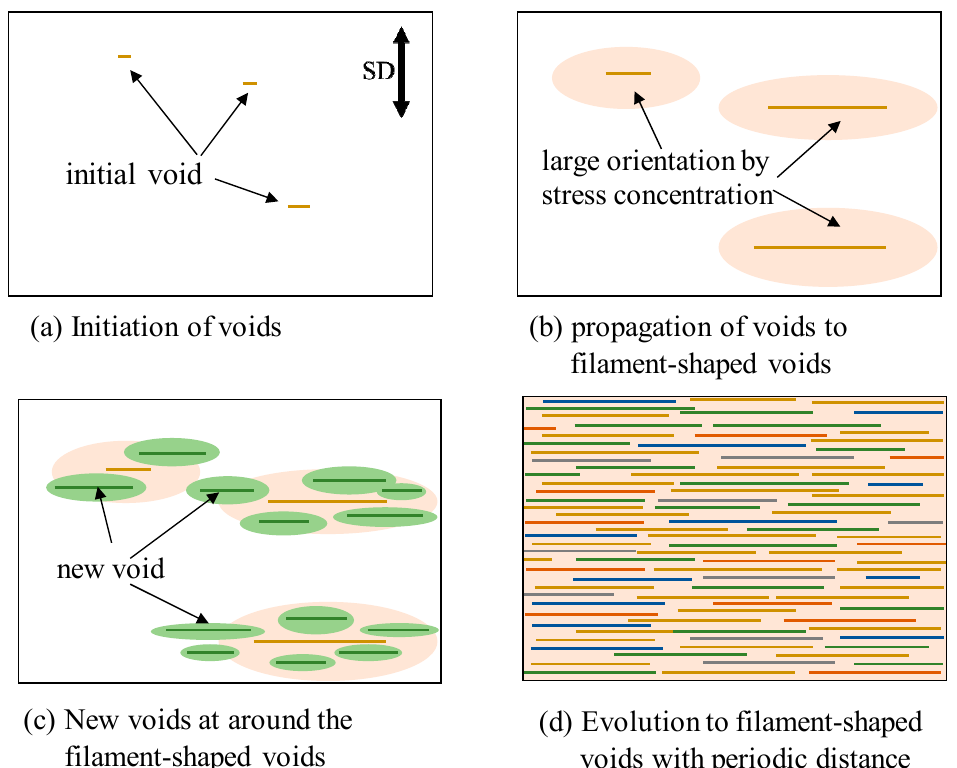
Figure 11. Schematic illustration for the evolution of a filament-shaped porous structure of OD-PC by stretching under CO 2 .